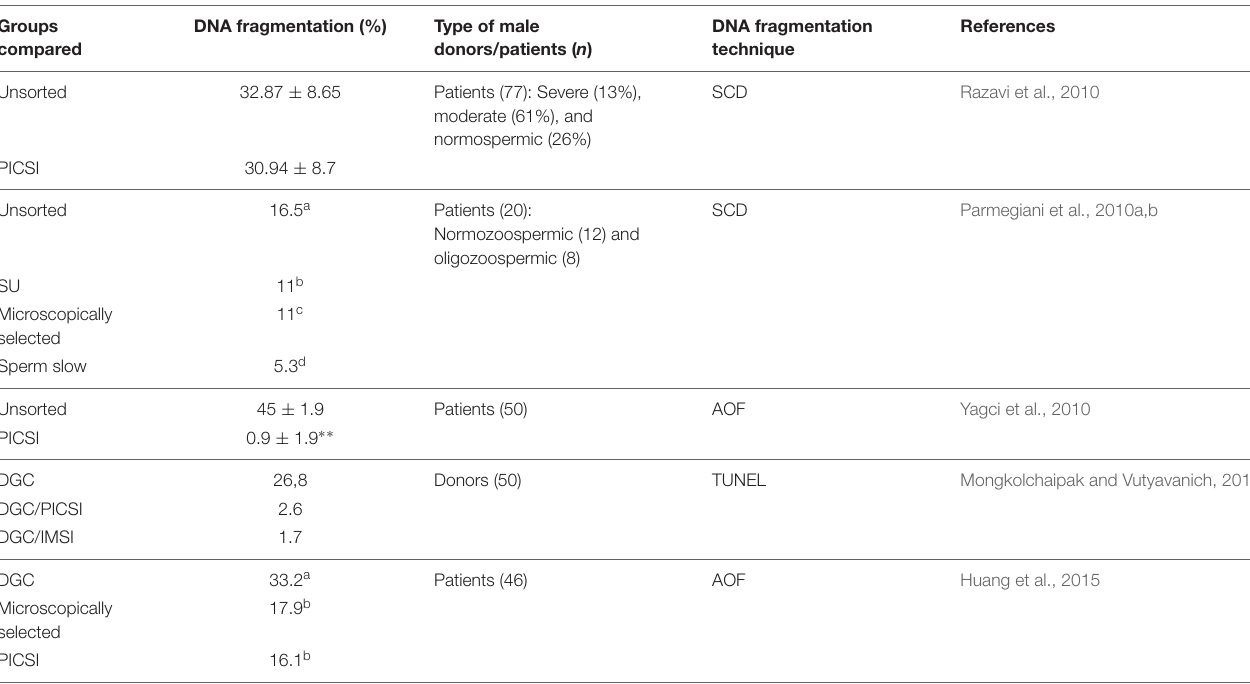
TABLE 3 | DNA fragmentation of spermatozoa selected by hyaluronic acid. Groups